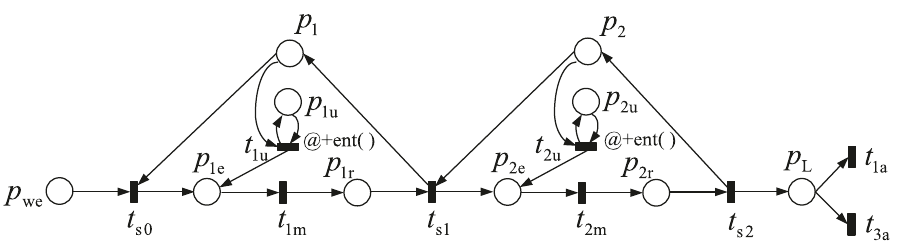
Figure 2: TCPN model of traffic flow on road section.